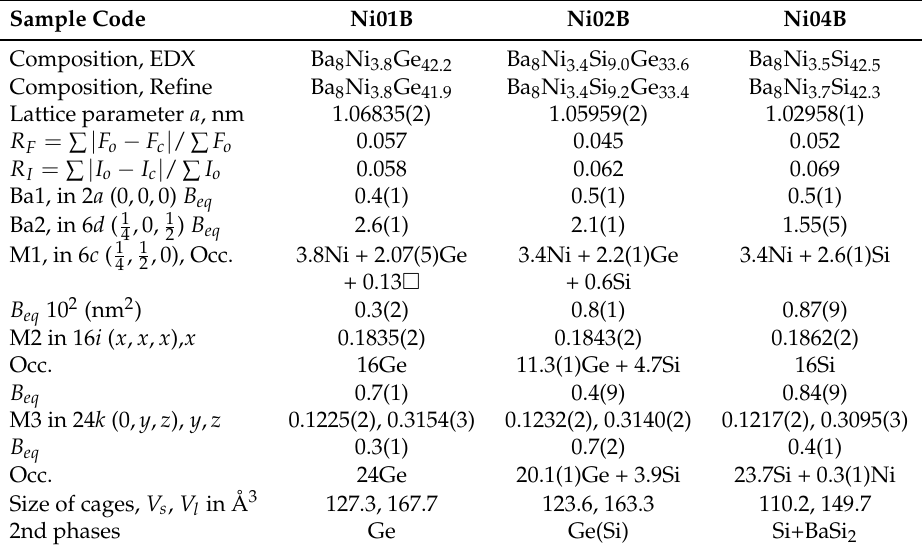
Table 1. Structure data for annealed samples Ni01B, Ni02B, and Ni04B. The Ni content was fixed to the results from EDX. No vacancies were assumed at the 6 c site. The unit for B eq is 10 2 (nm 2 ).